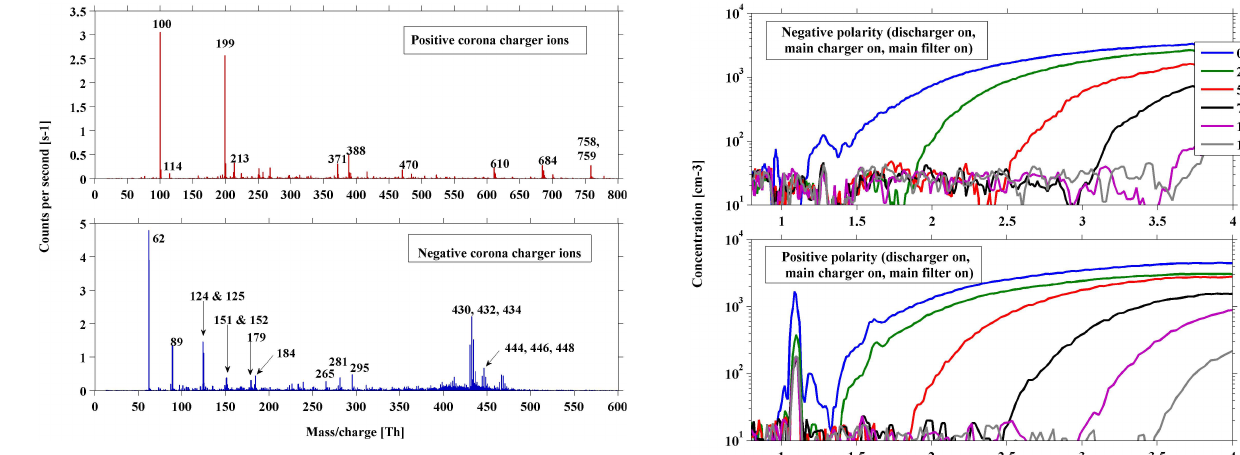
Fig. 7. The mass spectra of negative and positive ions generated by the corona discharge. The corona voltage was ± 3kV.